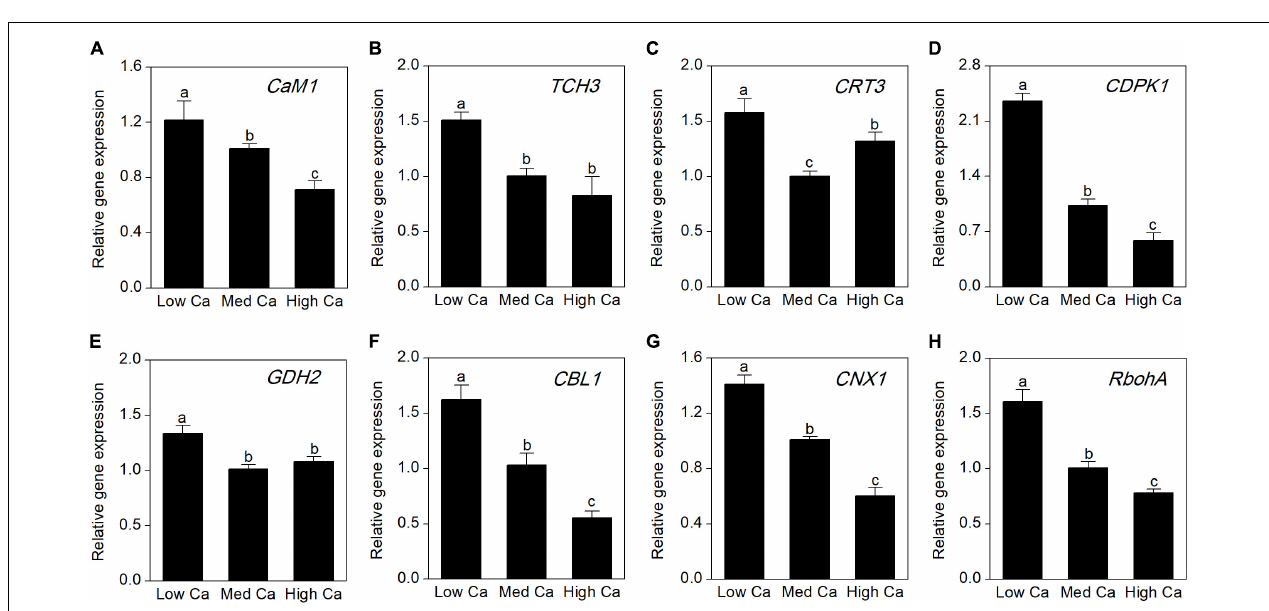
FIGURE 6 | Effects of different Ca levels on rubulose-1, 5-bisphoshate carboxylase–oxygenase large subunit (Rubisco LSU) (A) , ATP synthase (ATPase) (B) in T. wallichiana var. mairei under AR stress using western blot. Relative expression levels of Rubisco LSU (C) and ATPase (D) were analyzed with the Quantity One software. β -Actin was used as the internal control. Bars with different letters are significantly different from each other ( p < 0.05).